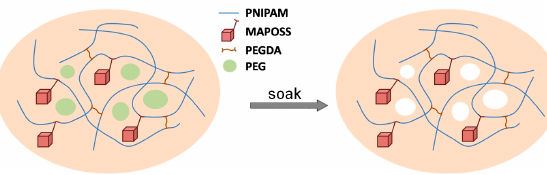
Figure 1. Schematic of preparation of PNIPAM-MAPOSS hybrid hydrogels.